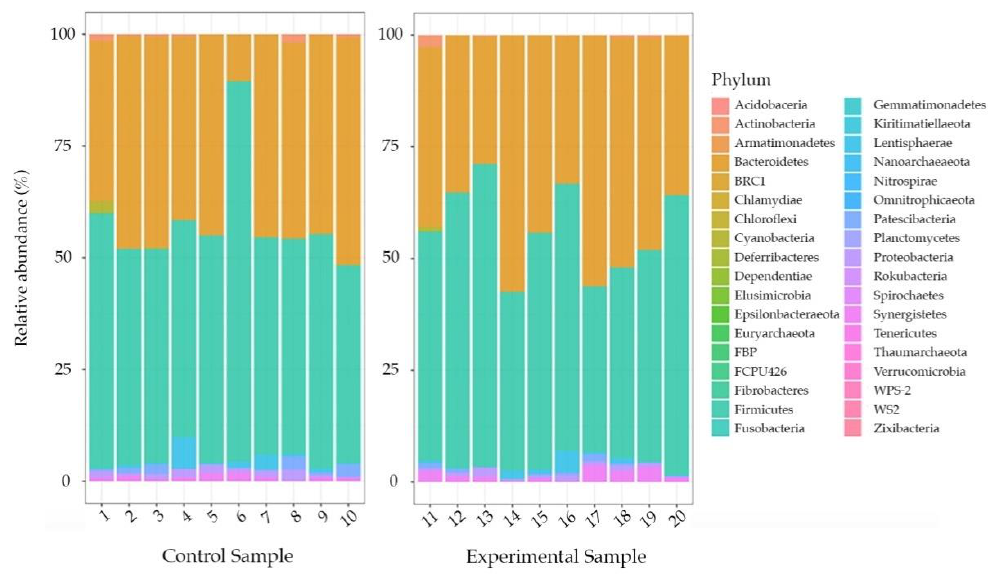
Figure 3. Bar plots showing the relative abundances of bacterial phyla in the control and experimental samples. We reported the ASVs > 3% of the whole community. The two groups showed similar bacterial composition.